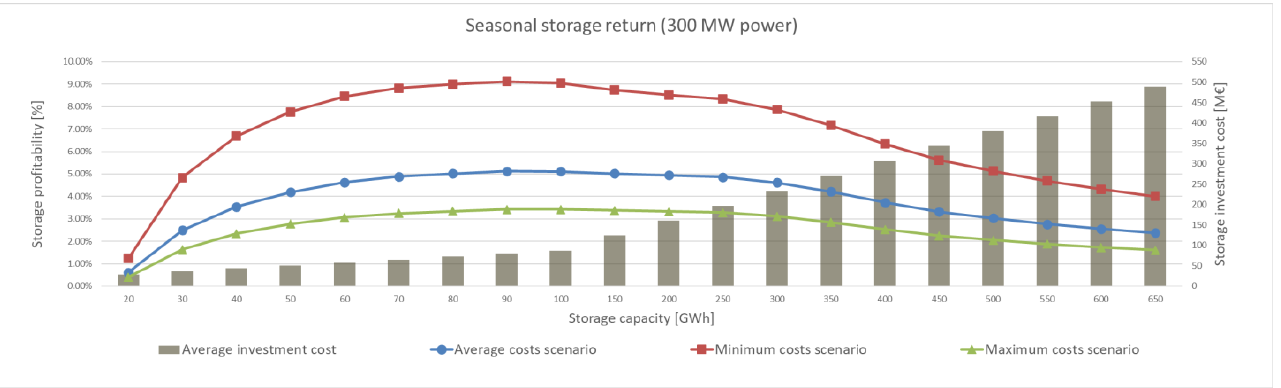
Figure A2. The 300 MW seasonal storage return.